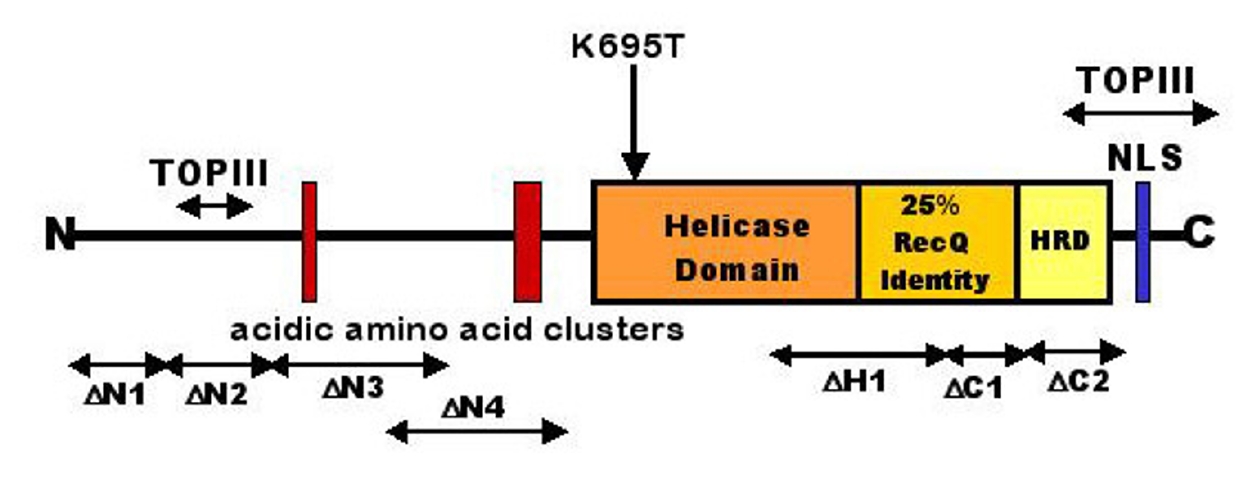
Figure 2 BLM Mutation Map. A diagram of the of the deletion and missense alleles of BLM used in this study. The amino acids removed by each deletion are: ∆ N1 (2-128), ∆ N2 (135-235), ∆ N3 (241-469), ∆ N4 (402-600), ∆ H1 (903-1115), ∆ C1 (1118- 1164) and ∆ C2 (1166-1331). The location of the missense allele K695T is shown. The red boxes indicate positions of regions of the N-terminus of BLM that have a high density of aspartic and glutamatic acid residues: region 1 (261-310 = 42% DE) and region 2 (541-570 = 50% DE). Deletion N3 removes a serine-rich region (310-320 = 64%S). The blue box indicates the location of the nuclear localization signal [29] (NLS = 1331-1350). The two regions of reported in vitro interaction of BLM with TopIII α (143-213 & 1266-1417) are marked [34]. The helicase domain consists of residues 672-985 and the HRD (Helicase and RNaseD identity domain) [41] is indicated (1212-1293).